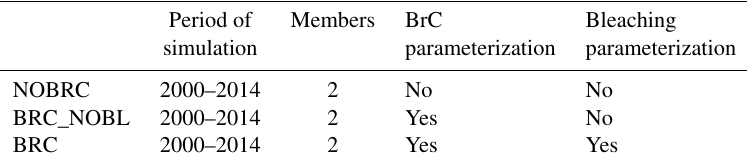
Table 3. Summary of the main characteristics of the three simulations used in this